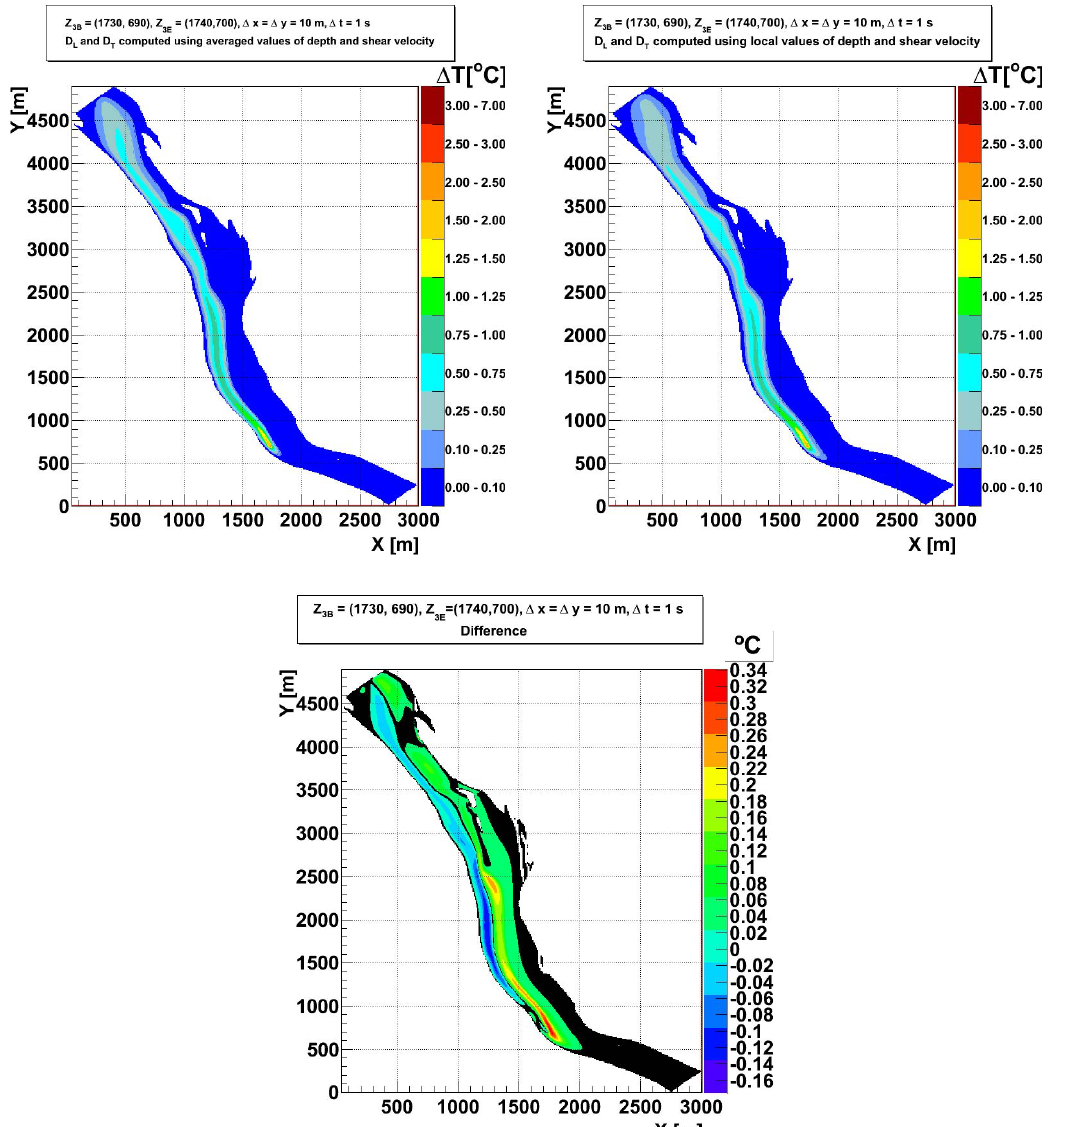
Fig. 9. Two-dimensional temperature distribution results for continuous discharge of 14m 3 s − 1 of heated water along a straight exit pipe, 14m long, located near the left bank of the river in case of using averaged (left-top chart) and local values of depth and shear velocity (right-top chart) for computing dispersion coefficients and difference between them (bottom chart). The beginning and end of the exit pipe are located, respectively, at points: Z 3B =(1730, 690), Z 3E =(1740, 700).